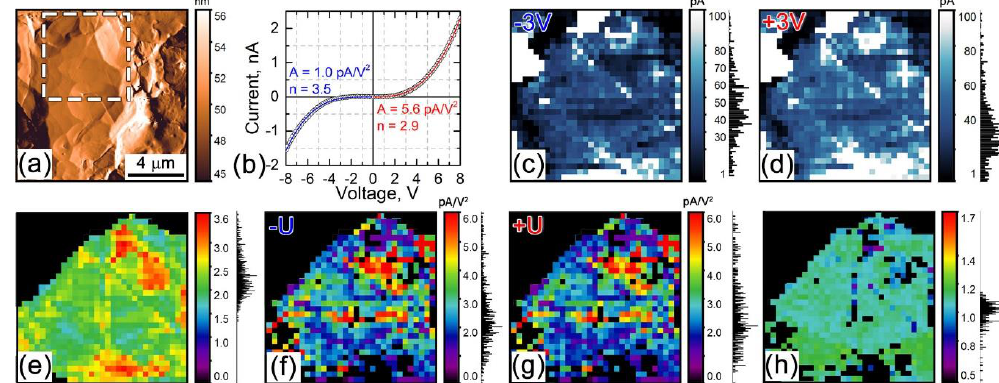
Figure 3. Analysis of local I−V curves and electric current distribution across the active ionic particle. ( a ) Differential topography (deflection error signal). The dashed line shows the 5.5 μm × 5.5 μm area where the I−V curve mapping was performed. ( b ) Typical I−V curve (circles) with a fit by Equation (4) (solid line). ( c ) Current distribution map for V dc = −3 V. ( d ) Current distribution map for V dc = +3 V. Maps of parameters A and n found by fitting local I−V curves by Equation (4): ( e ) n, ( f ) A − , ( g ) A + , ( h ) A + /A −. Black areas in ( e-h ) are regions inside the binder that do not show the typical I−V curve shape. For the images in ( c – h ), corresponding signal histograms are displayed on the right from the color scalebars.